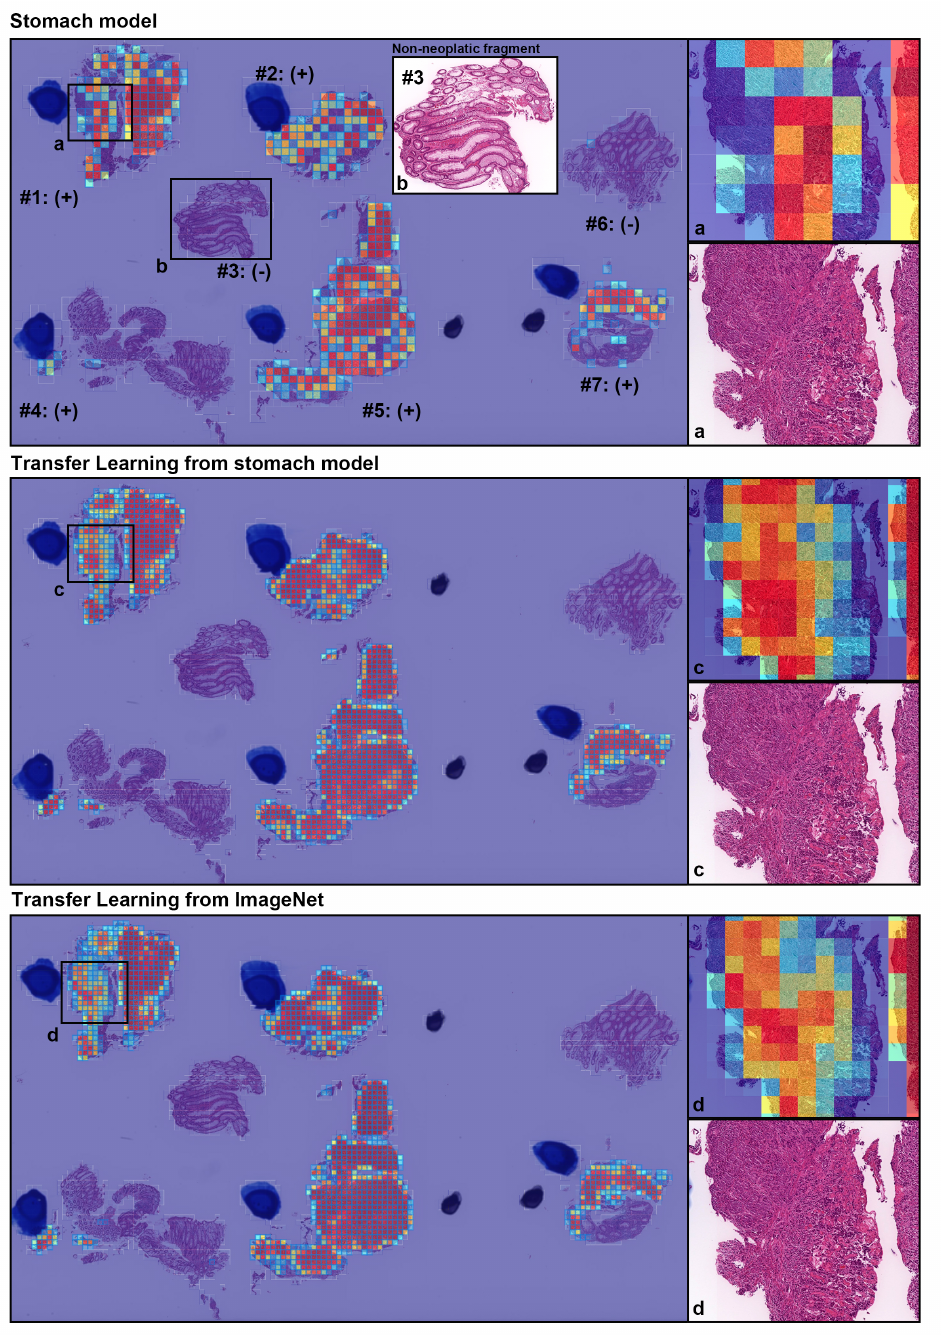
Figure 3. A representative true positive poorly differentiated colorectal ADC case from the endoscopic biopsy test set. Heatmap images show true positive predictions of poorly differentiated ADC cells and they correspond, respectively, to H&E histopathology (a, c, d) using stomach model ( upper panel ), transfer learning from stomach model ( middle panel ), and transfer learning from ImageNet model ( lower panel ). According to the pathological diagnosis provided by surgical pathologists, histopathological evaluation for each tissue fragment is as follows: #1, #2, #4, #5, and #7 were positive for poorly differentiated ADC; #3 and #6 were negative for poorly differentiated ADC. The high magnification image (b) shows representative H&E histology (#3 fragment), which is negative for poorly differentiated